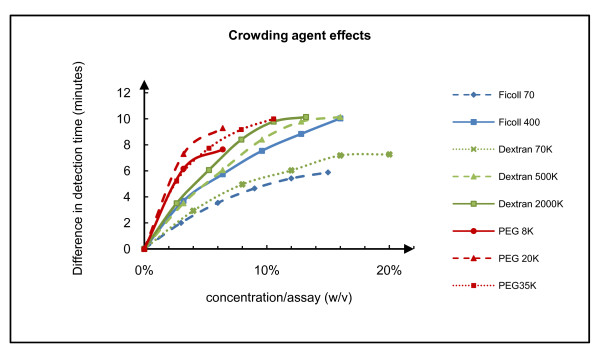
Effects of macromolecular crowding reagents. The effects are shown as the difference in detection time (calculated by: 2 × (Ttreaction without crowding agent- Ttreaction with crowding agent )) relative to non chemical control reactions versus crowding agents concentration in the final assay. The blue groups represent the effects of Ficoll, the green groups represent the effects of Dextran, the red groups represent the effects of PEG. The maximal tested concentration of each chemical is limited by its solubility (stock concentration) or viscosity (transferable or not by pipette).